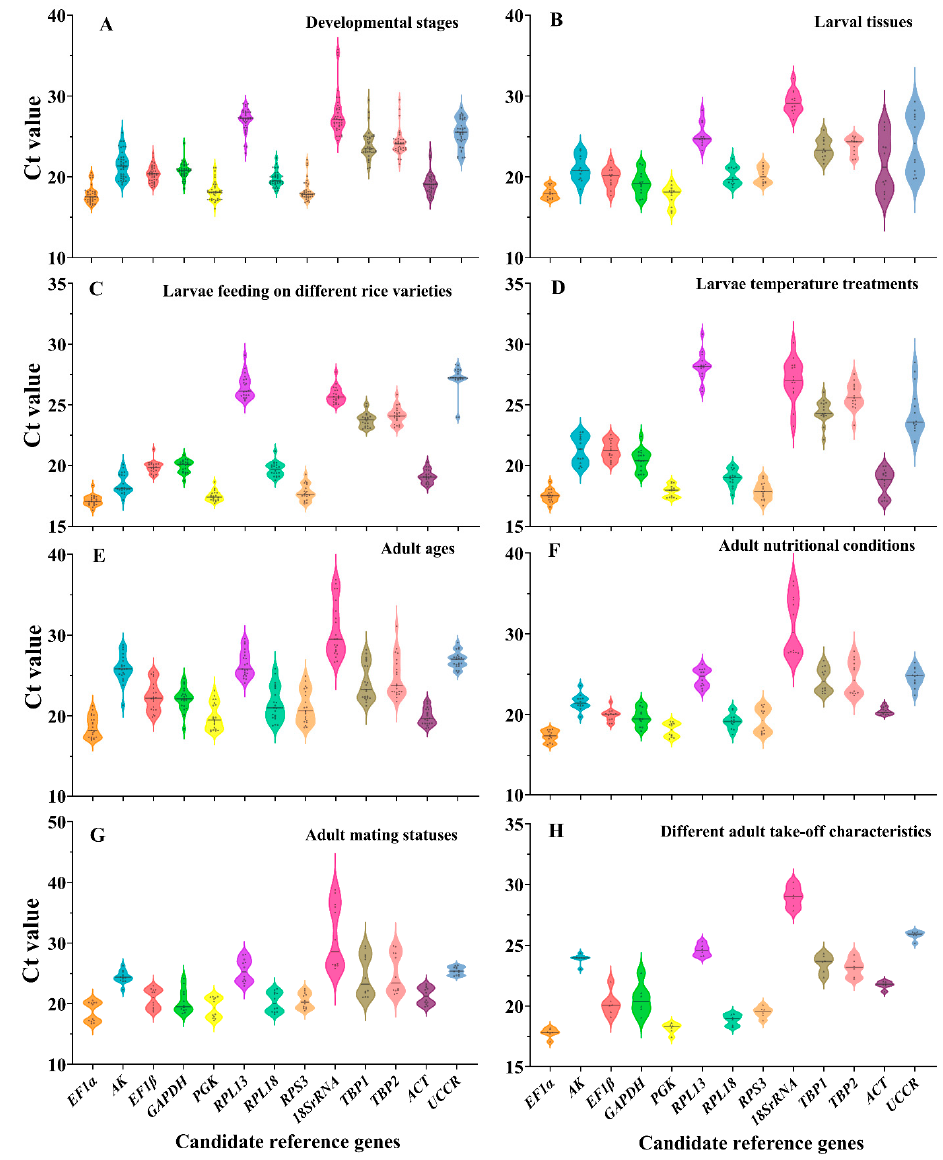
Figure 1. Expression profiles of candidate reference genes under eight experimental conditions. ( A ) developmental stages; ( B ) larval tissues; ( C ) larvae feeding on different rice varieties; ( D ) larvae temperature treatments; ( E ) adult ages; ( F ) adult nutritional conditions; ( G ) adult mating statuses; ( H ) different adult take-off characteristics. Lines across the Violin plots depict the medians of Ct values. Black dots represent measured values (jitter effect was applied to avoid